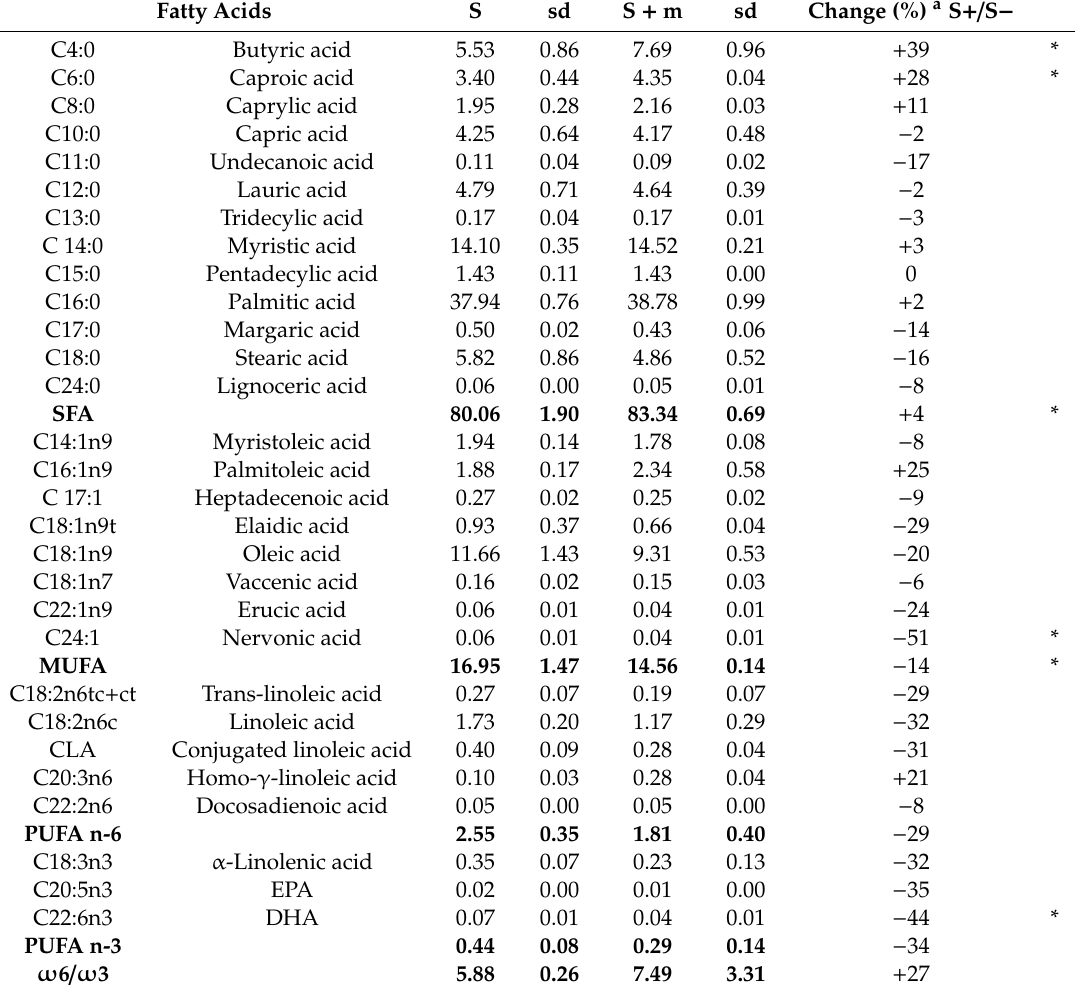
Table 2. Fatty acid composition (% of total fatty acids) of milk obtained from cows fed nonmycorrhizal (S) and mycorrhizal (S + m) sorghum silage (% weight of total methyl esters; mean ± standard